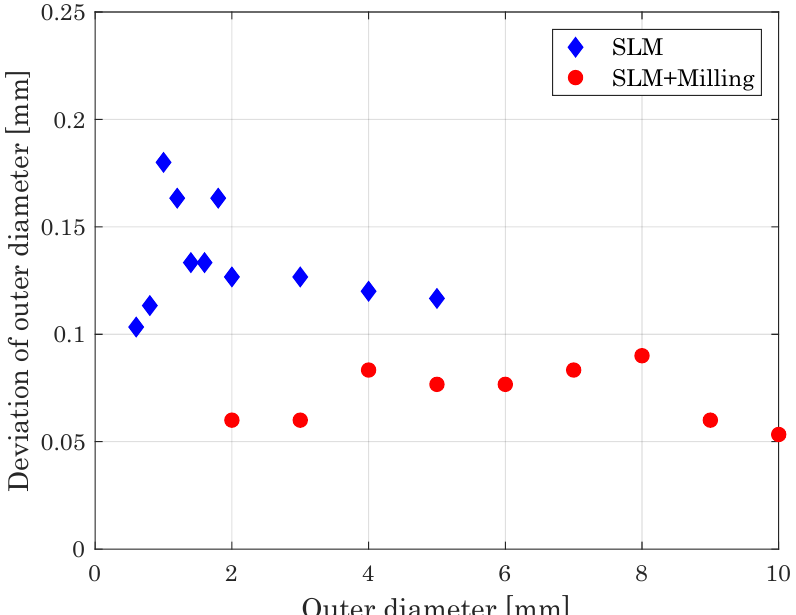
Figure 14. Deviation of outer diameter of spheres versus intended outer diameter, giving a measure of the dimensional accuracy of the